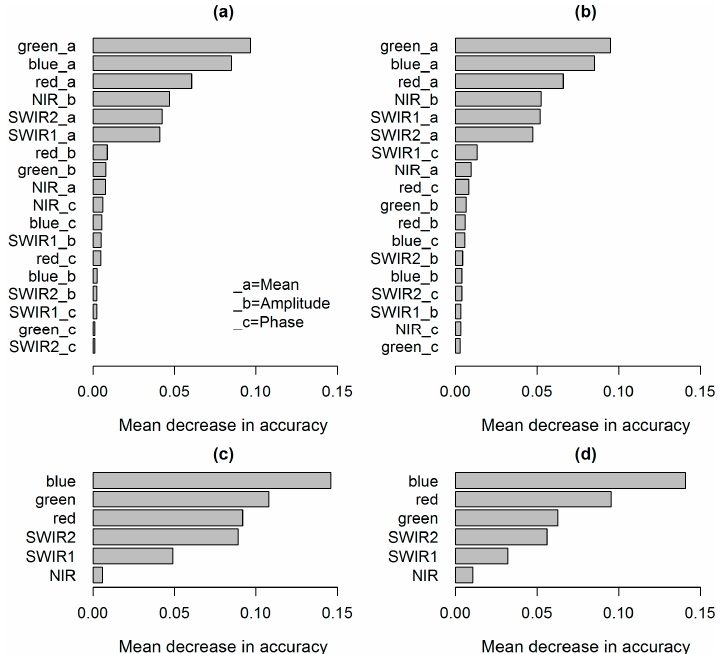
Figure 7. Variable importance for land cover classifications based on the seasonal features ( a ) before and ( b ) after burnt area removal; and ( c ) dry season and ( d ) rainy season images. The most important variables are those with the highest mean decrease in accuracy.